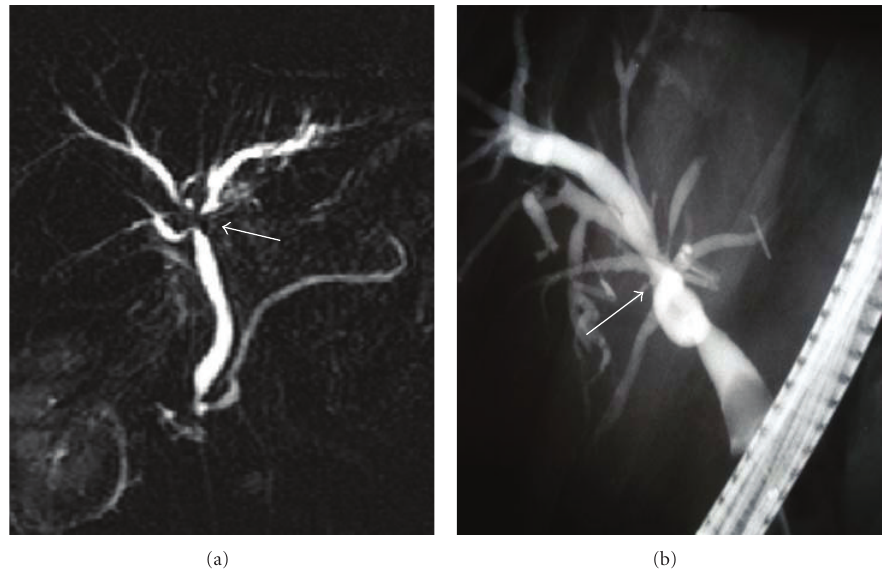
Figure 5: In a case who had undergone laparoscopic cholecystectomy operation 3 years ago, MRCP image demonstrates (a) stricture at hilar level (arrows) and mild dilatation of left main hepatic duct. Although this case had received false positive diagnosis as malignant stricture with MRI and MRCP findings, during ERCP, benign stricture developed secondary to cholecystectomy was diagnosed (arrows). Balloon dilatation and stent replacement was performed during ERCP procedure, and the result of biopsy was benign.